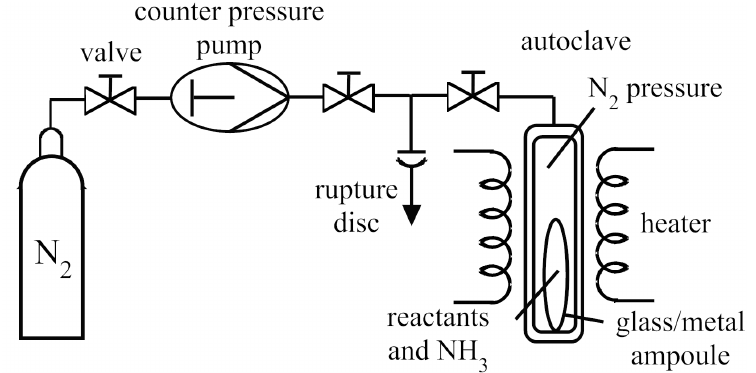
Figure 5. Flow chart of an ammonothermal reaction setup using a glass or metal ampoule filled with ammonia and the reactants placed in a steel autoclave connected to a high pressure pump, applying a counter-pressure of nitrogen